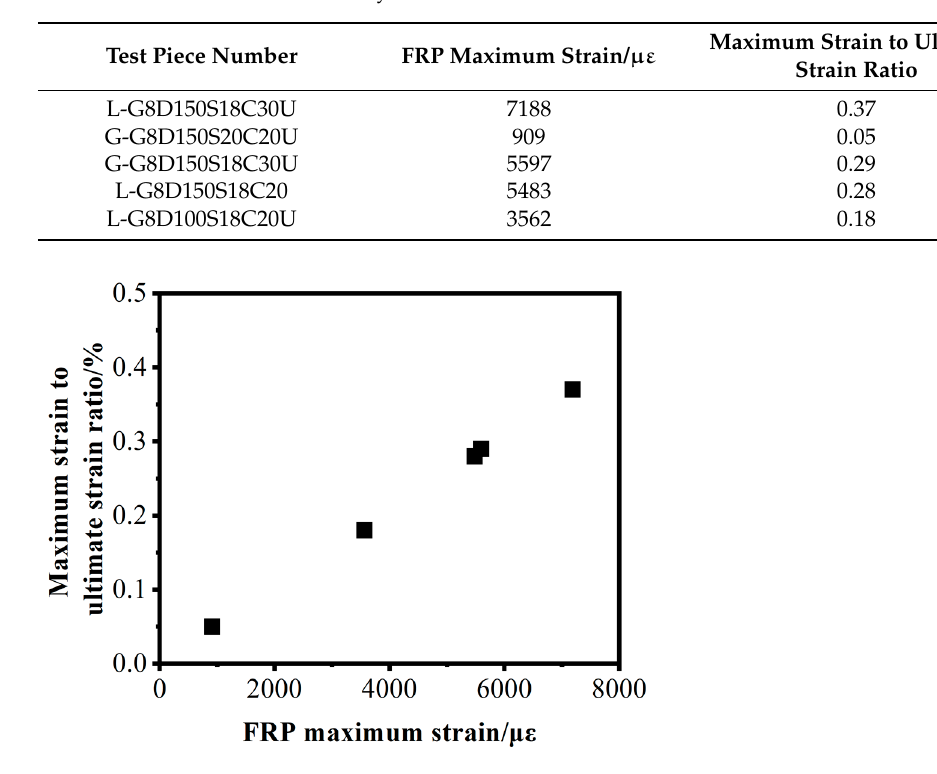
Table 9. Comparison of experimental values with theoretical values of V f